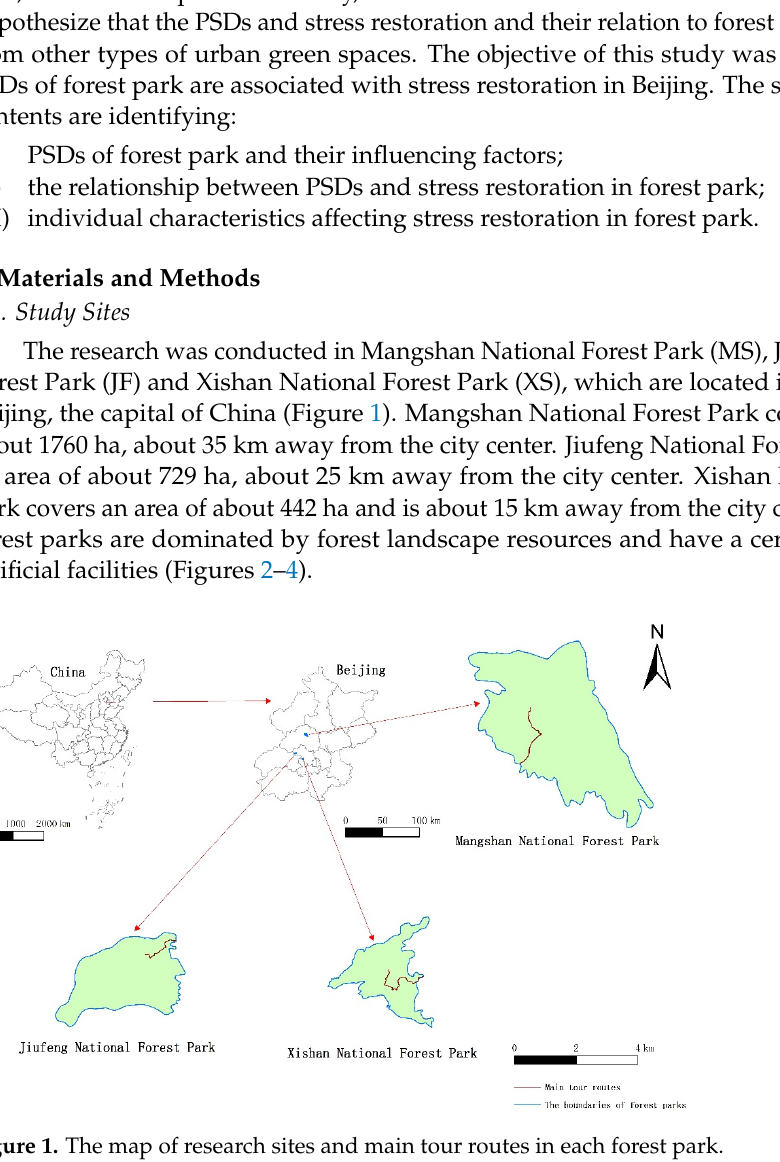
( b ) Figure 2. Forest landscape and artificial facilities in Mangshan National Forest Park (MS): ( a ) Forest landscape; ( b ) Artificial facilities. ( a ) ( b ) Figure 3. Forest landscape and artificial facilities in Jiufeng National Forest Park (JF): ( a ) Forest land- scape; ( b ) Artificial facilities.